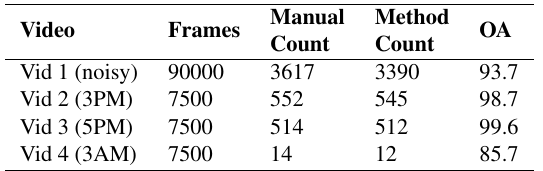
Table 3: Validation of detection of vehicles (count) in adverse lighting conditions.